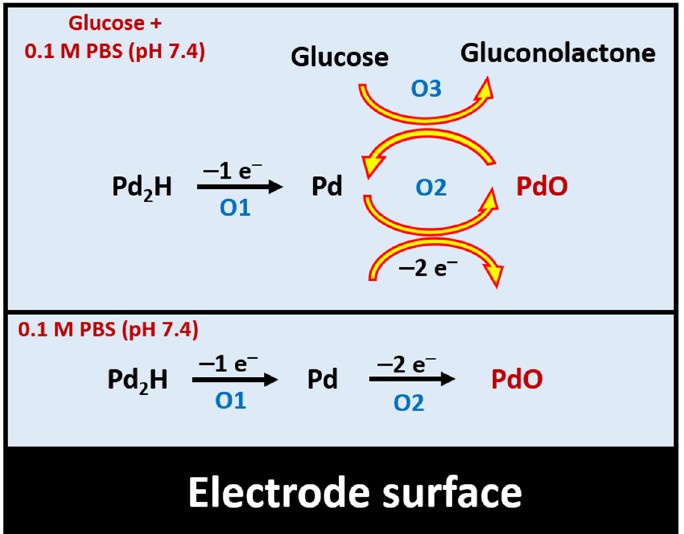
Figure 5. Schematic illustration of a proposed glucose oxidation mechanism on PdNS/f-CNT/SPCE in 0.1 M PBS with and without glucose.